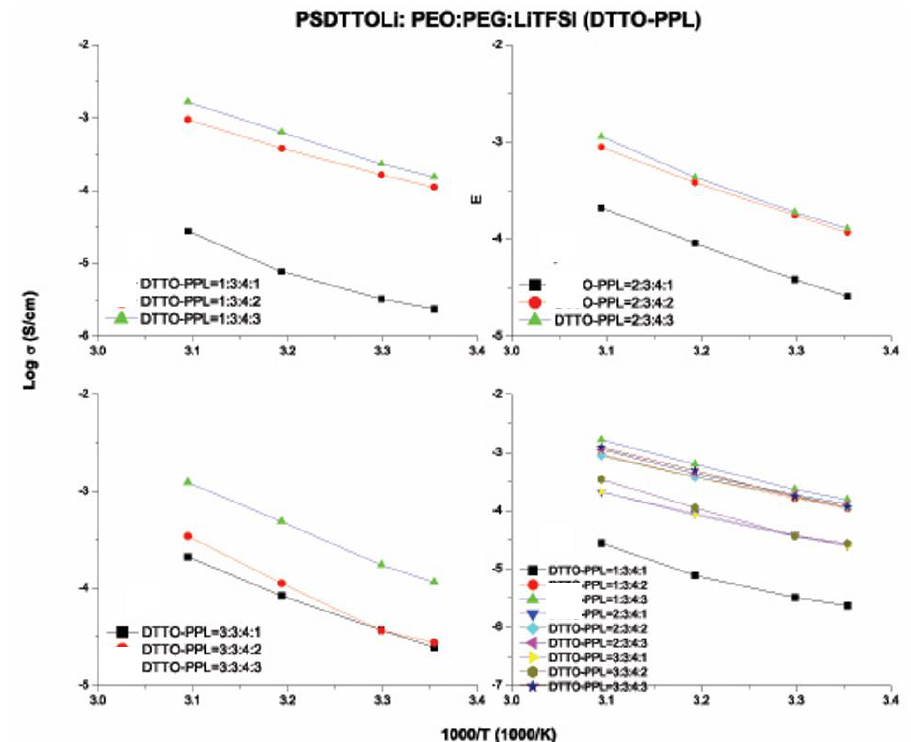
Figure 13. Ionic conductivity versus temperature of various weight ratios of PSPhSILi–PEO–PEGDM– LiTFSI (DTTO–PPL) electrolytes.